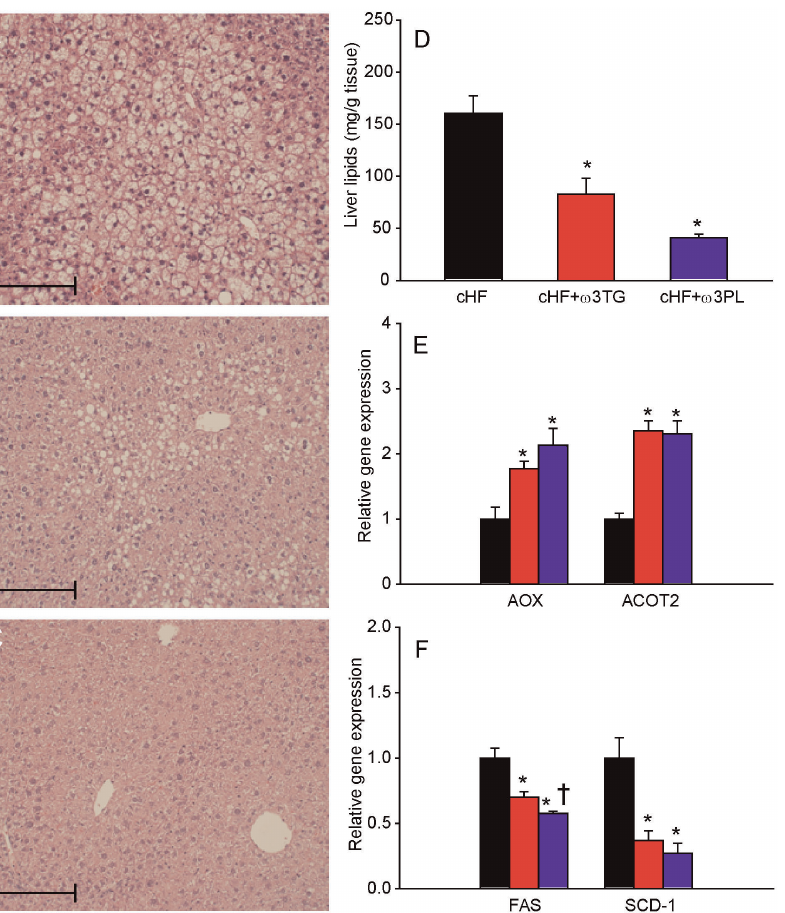
Figure 4. Reversal of hepatic lipid accumulation by dietary LC n -3 PUFA. Following a 4-month period of cHF-feeding, mice were fed for additional 9 weeks with cHF diet or treated using either cHF + v 3TG or cHF + v 3PL diet supplemented with 30 g DHA/EPA per kg; all diets also contained 2 g metformin per kg. Hematoxyline-eosin staining of liver sections from mice fed cHF ( A ), cHF + v 3TG ( B ), or cHF + v 3PL ( C ) diet. Hepatic lipid content ( D ). Quantification of mRNA levels of fatty acid oxidation ( E ) and lipogenic ( F ) genes in mice fed cHF (black bars), cHF + v 3TG (red bars), or cHF + v 3PL (blue bars) diets. A-C , Scale bars=200 m m. AOX, acyl-CoA oxidase; ACOT2, acyl-CoA thioesterase 2; FAS; fatty acid synthase; SCD-1, stearoyl-CoA desaturase 1. Data are means 6 SEM ( n =7). *Significantly different from cHF (t-test or ANOVA); { significantly different from cHF + v 3TG (ANOVA).